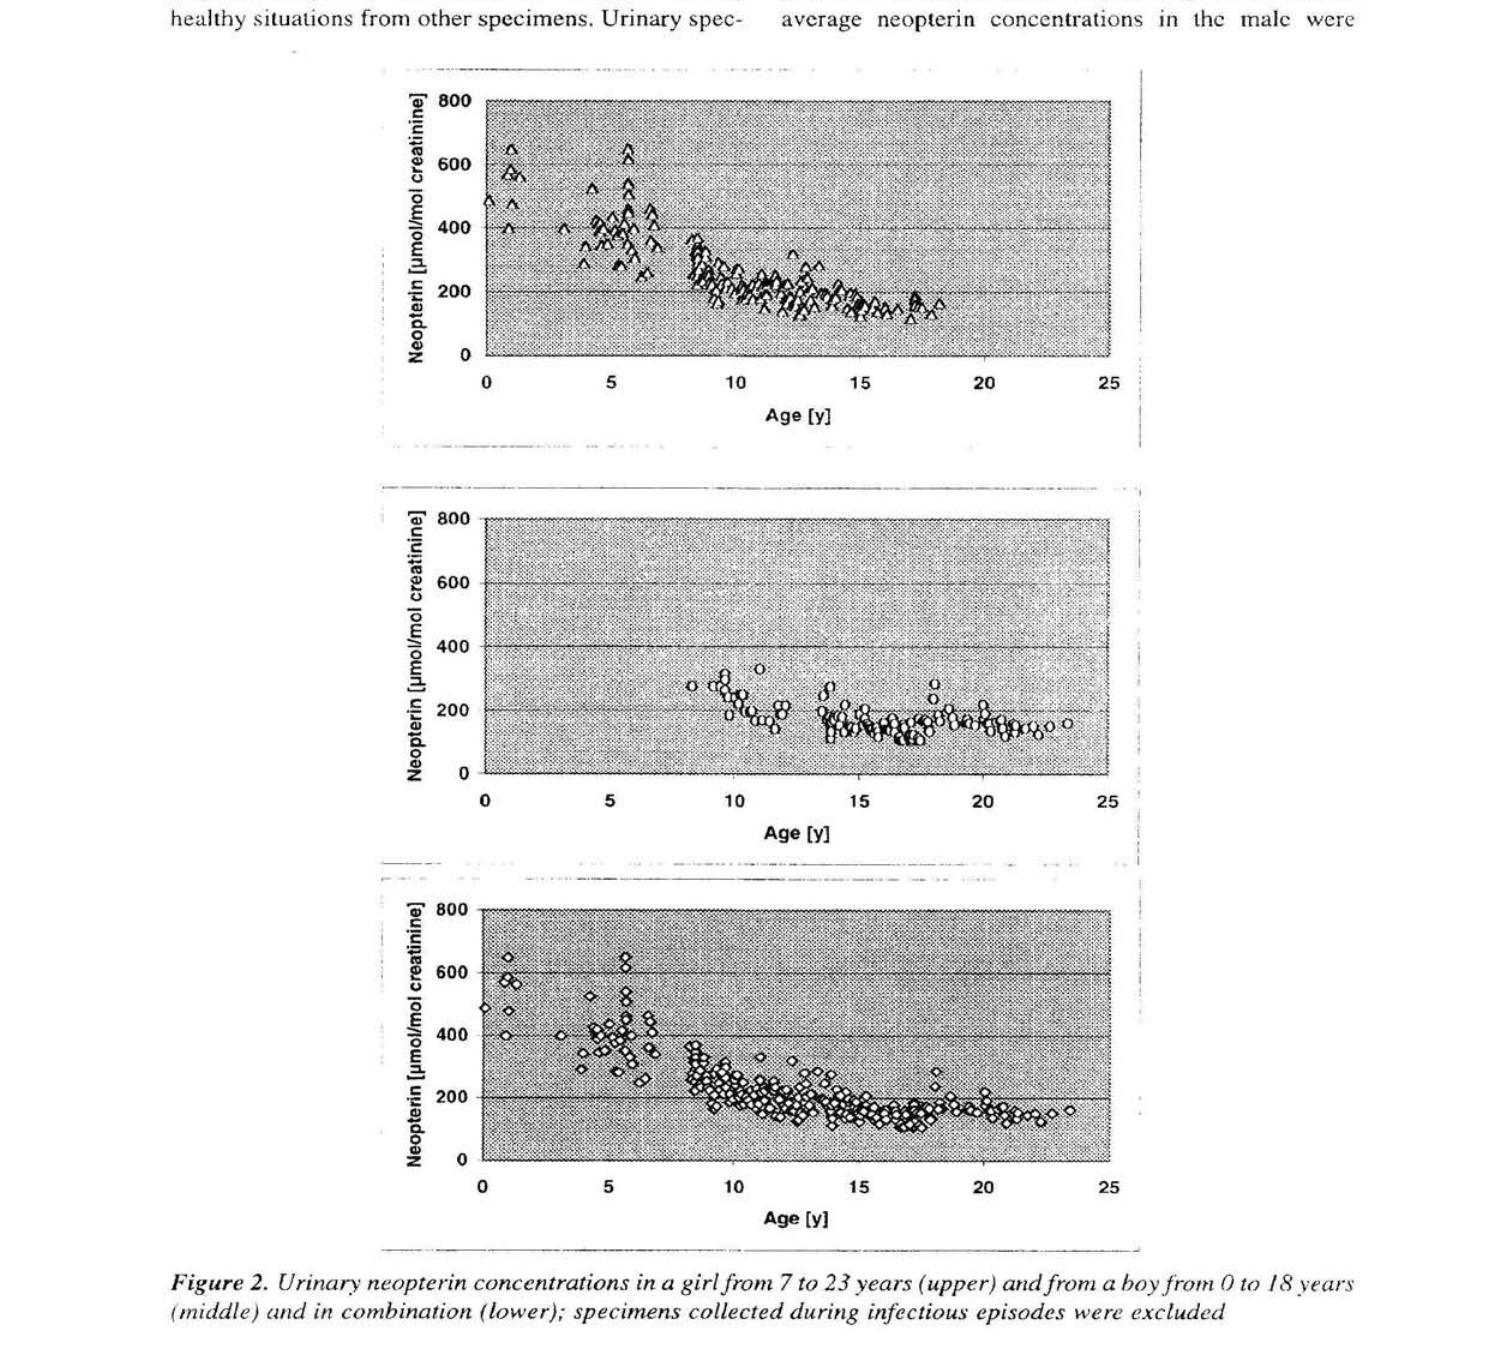
Figure 2. Urinary neopterin concentrations in a girl from 7 to 23 years ( upper) and from a boy from 0 to 18 years (middle) and in combination (lower); specimens collected during infectious episodes were excluded